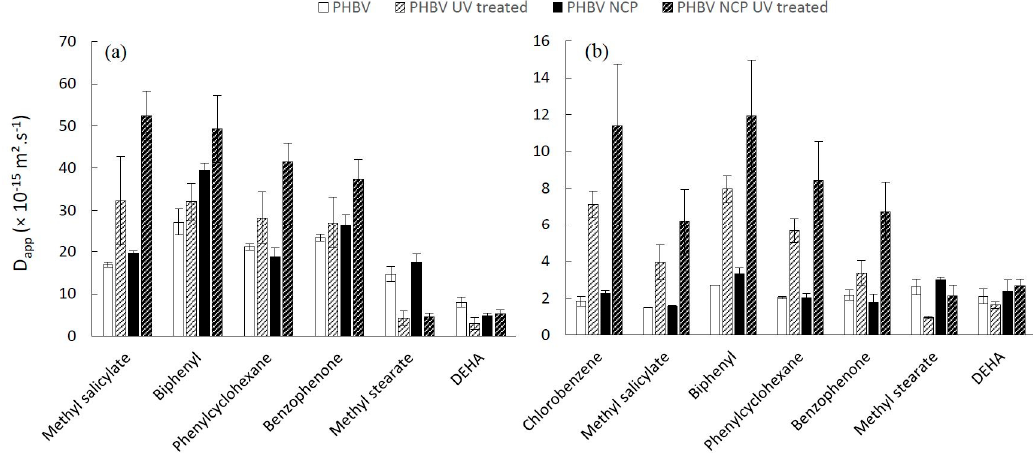
Figure 7. Comparison of D app values of additives in PHBV, PHBV NCP and the corresponding aged materials in contact with 95% ethanol ( a ) and isooctane ( b ). materials in contact with 95% ethanol ( a ) and isooctane ( b